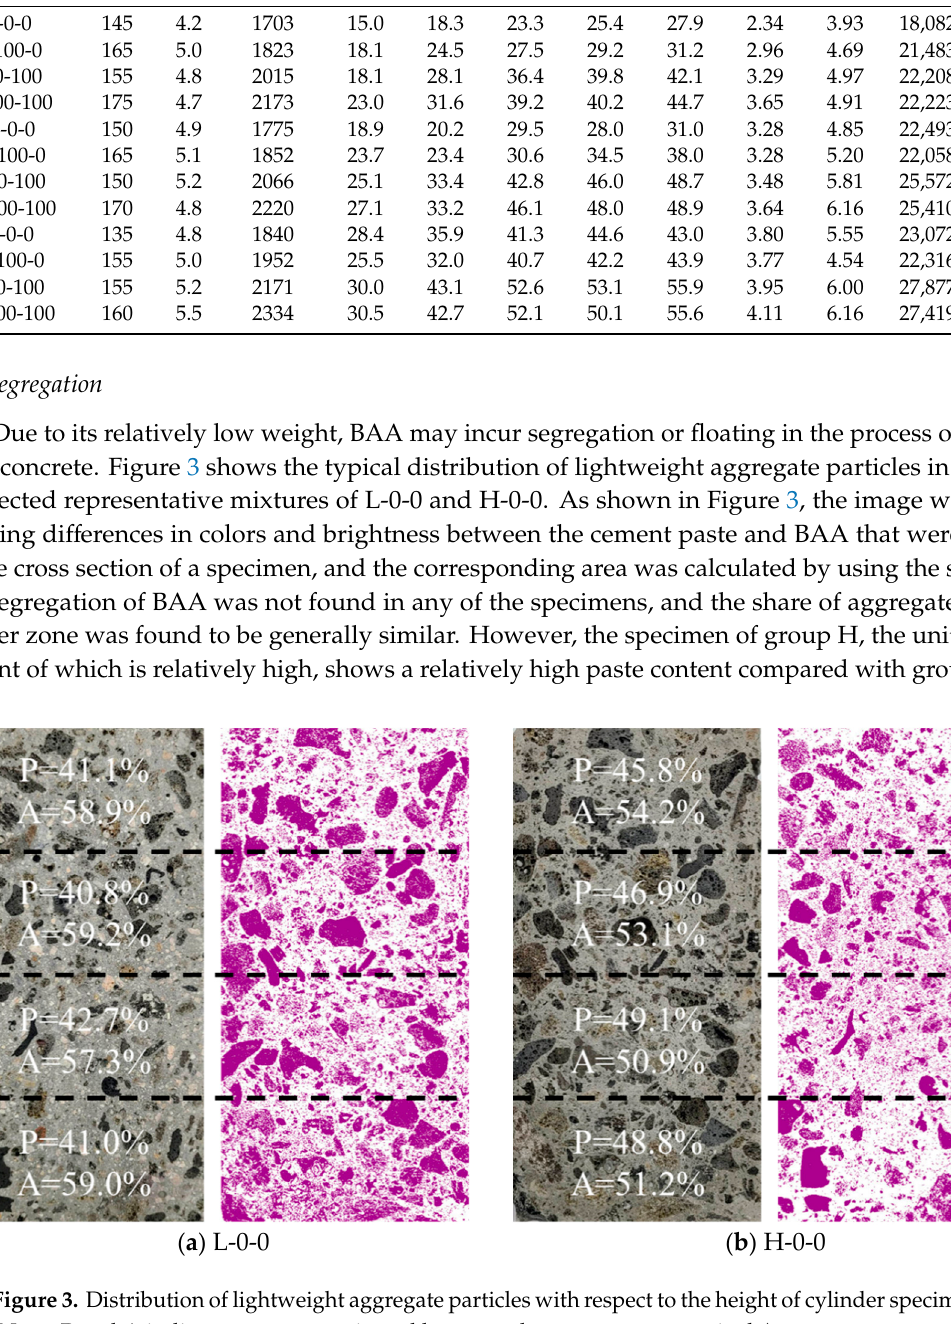
Table 4. Summary of the test results.